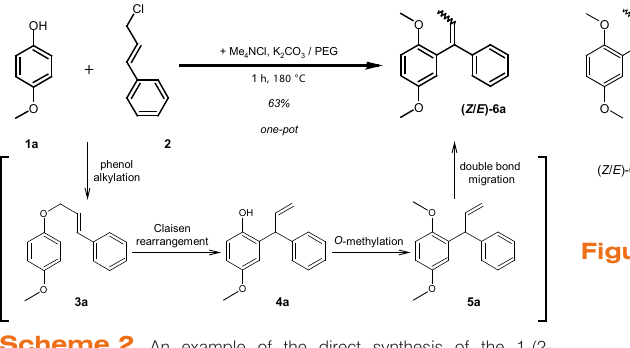
Figure 1. Compounds 6 prepared using the alkylation- rearrangement-methylation-isomerization one-pot reaction